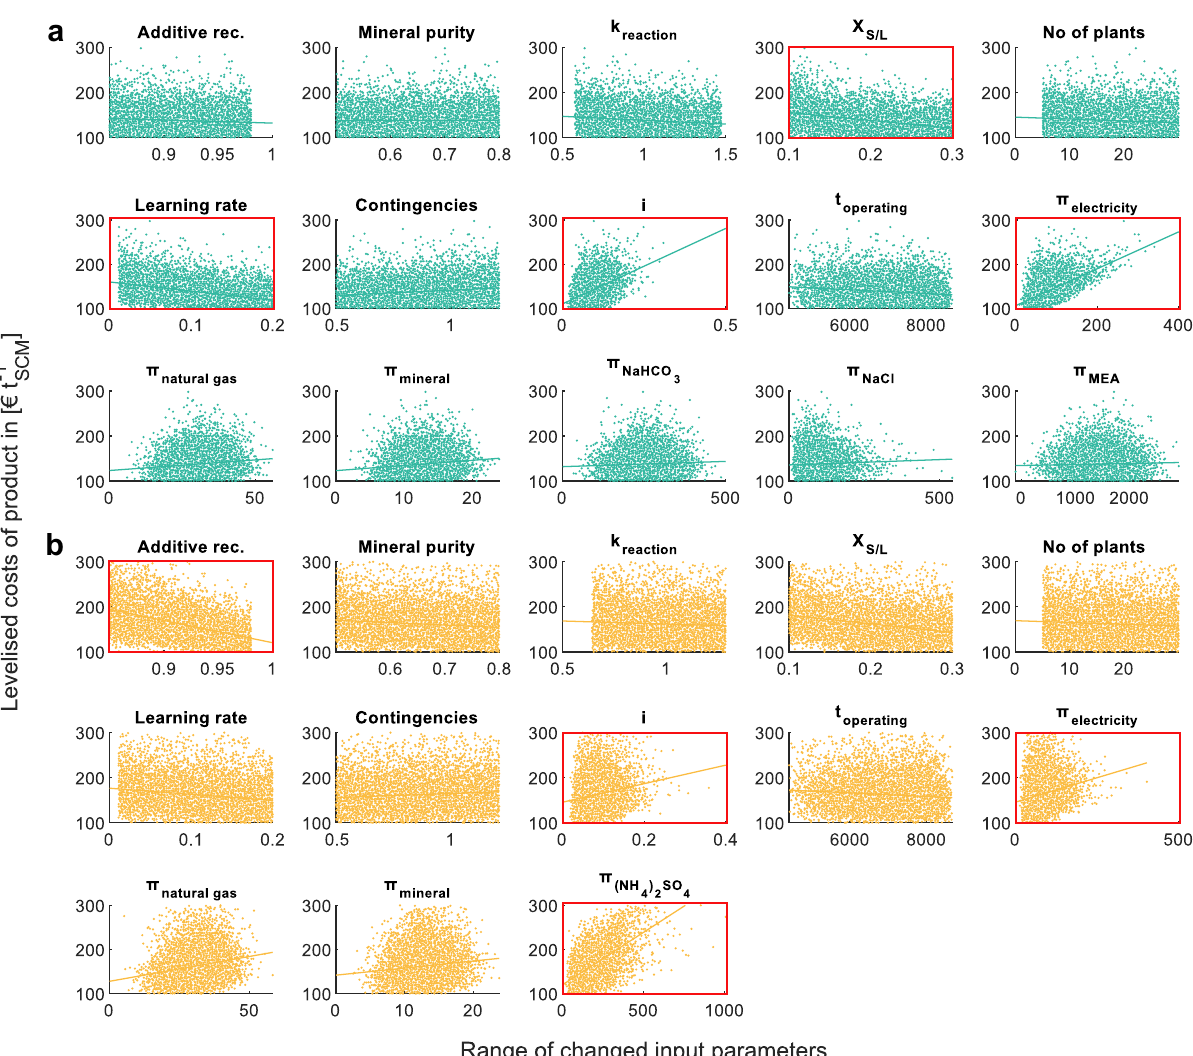
Fig. 4 Distribution of levelised costs of product (LCOP) for mid scenario. a Direct process (green scatters and green linear regression lines). b Indirect process (beige scatters and beige linear regression lines). a , b Frequencies derived by Monte Carlo simulation using 10,000 runs with changing input parameters: Additive recovery (Additive Rec.) [fraction], Mineral purity [fraction], reaction rate constant ( k reaction ) [s], solid-liquid ratio in reactor ( X S/L ) [fraction], Number of plants to reach maturity (No of plants) [natural number], Learning rate on capital costs (Learning rate) [fraction], combined process and project contingencies (Contingencies) [fraction], interest rate on capital ( i ) [fraction], operation hours per year ( t operating ) [h], electricity